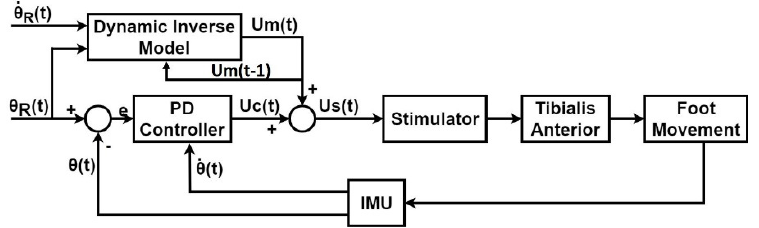
Figure 3. Closed-loop, Trajectory tracking control diagram, including the PD controller as the feed- back component and the Dynamic Inverse Model (NARXNN) as the feedforward component. The control command 𝑈 (cid:3046) (𝑡) (pulse width) is generated by combining the feedforward control command ( 𝑈 (cid:3040) (𝑡) ) and the feedback control command ( 𝑈 (cid:3030) (𝑡) ) and is sent to the stimulator, which delivers the stimulation to tibialis anterior muscle accordingly. The subsequent foot movement is continuously measured by the IMU placed on the subject’s foot in terms of real foot angular velocity 𝜃(cid:4662)(𝑡) and foot angle 𝜃(t) . The PD controller only considered the foot angle 𝜃 (cid:3019) (t) as the reference trajectory, while the Dynamic Inverse Model (NARXNN), considered as references both the foot angle 𝜃 (cid:3019) (t) and the foot angle velocity 𝜃 (cid:3019) (cid:4662) (𝑡) . The error value, 𝑒(𝑡) , represents the PD controller input and it is computed as indi- cated in Equation (3).